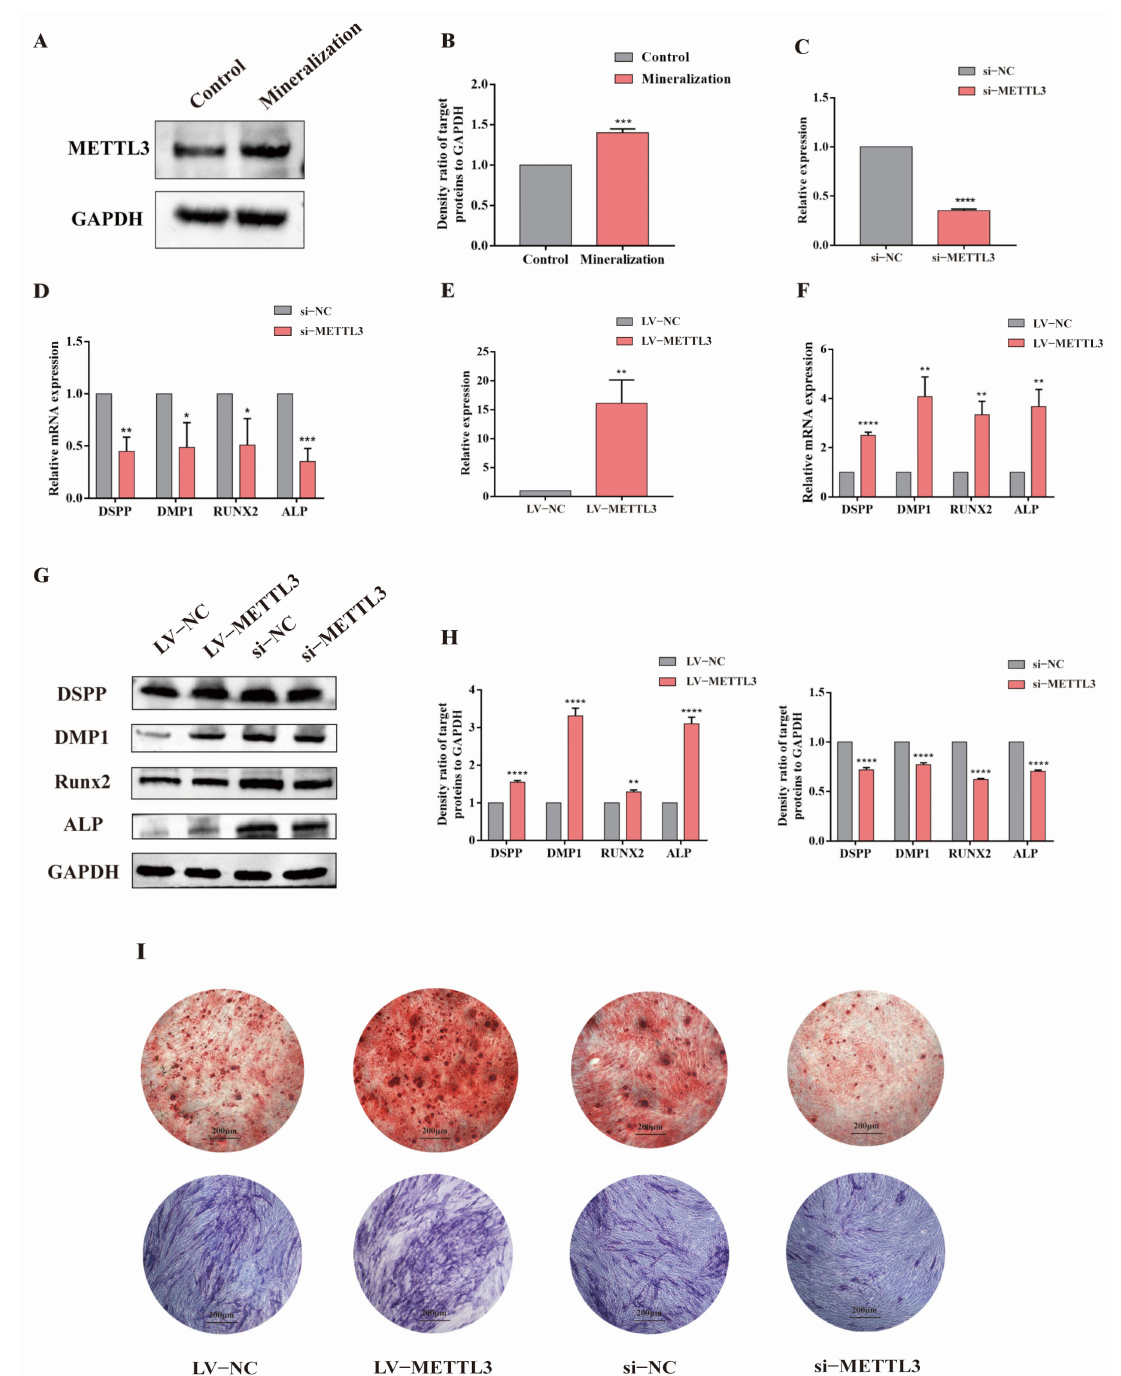
Figure 3. METTL3 promoted osteogenic/odontogenic differentiation of hDPSCs. ( A ) The protein expression of METTL3 detected by Western blot. ( B ) The density ratio of target proteins to GAPDH. ( C , E ) The knockdown and overexpression effect of si-METTL3 and LV-METTL3 detected by qRT-PCR. ( D , F ) mRNA expressions of osteogenic/odontogenic genes detected by qRT-PCR after the knock- down and overexpression of METTL3. ( G ) Western blot results showed the expression level of osteogenic/odontogenic proteins decreased in the si-METTL3 group and increased in the LV-METTL3 after mineralization. ( H ) The density ratio of target proteins to GAPDH. ( I ) ARS and ALP staining after the knockdown and overexpression of METTL3. The data were represented as means ± SD for each group: * p < 0.05, ** p < 0.01, *** p < 0.001, **** p <